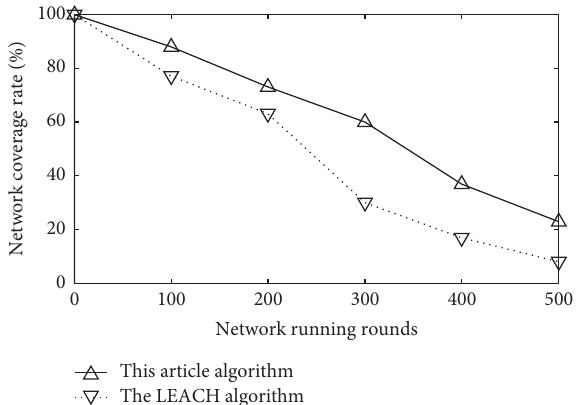
Figure 8: Energy consumption comparison in this article’s algo- rithm and the LEACH algorithm under different network running rounds (when s �